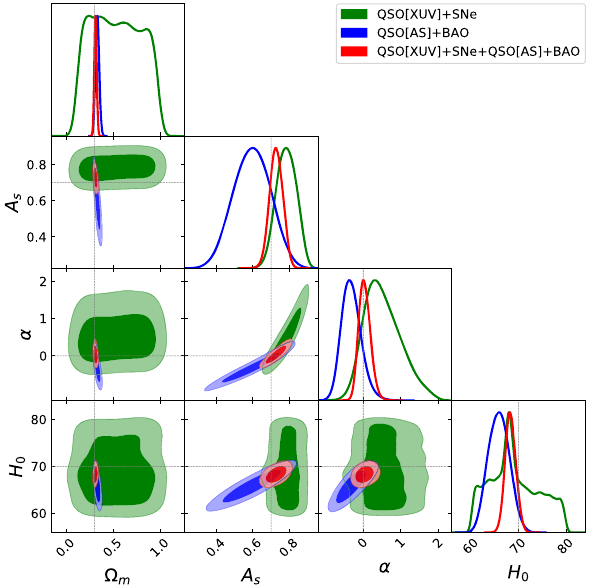
Fig. 2 The 1D and 2D probability distributions of model parame- ters in the GCG model, based on the QSO[XUV]+SNe Ia(green), QSO[AS]+BAO (blue), and a joint sample (red). The contours cor- respond to 68% and 95% confidence levels. The grey line indicates the values of the model parameters that can be recovered to the Λ CDM scenario, with the fiducial value of Ω m = 0 . 30, ω = − 1, α = 0 and H 0 = 70 km/s/Mpc ( H 0 = 67 . 66 ± 0 . 42 km/s/Mpc) [54], although the